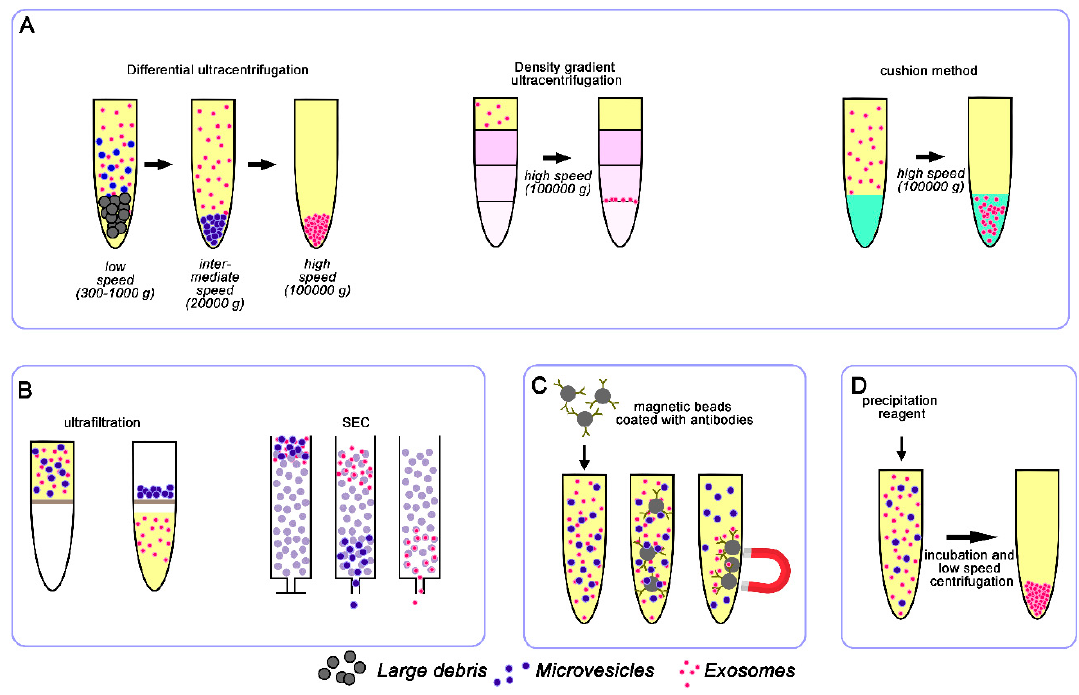
Figure 2. Schematic representation of conventional exosome isolation techniques. The most widely used techniques are based on ultracentrifugation ( A ), size ( B ), immunoaffinity ( C ), and precipitation reagents ( D ).